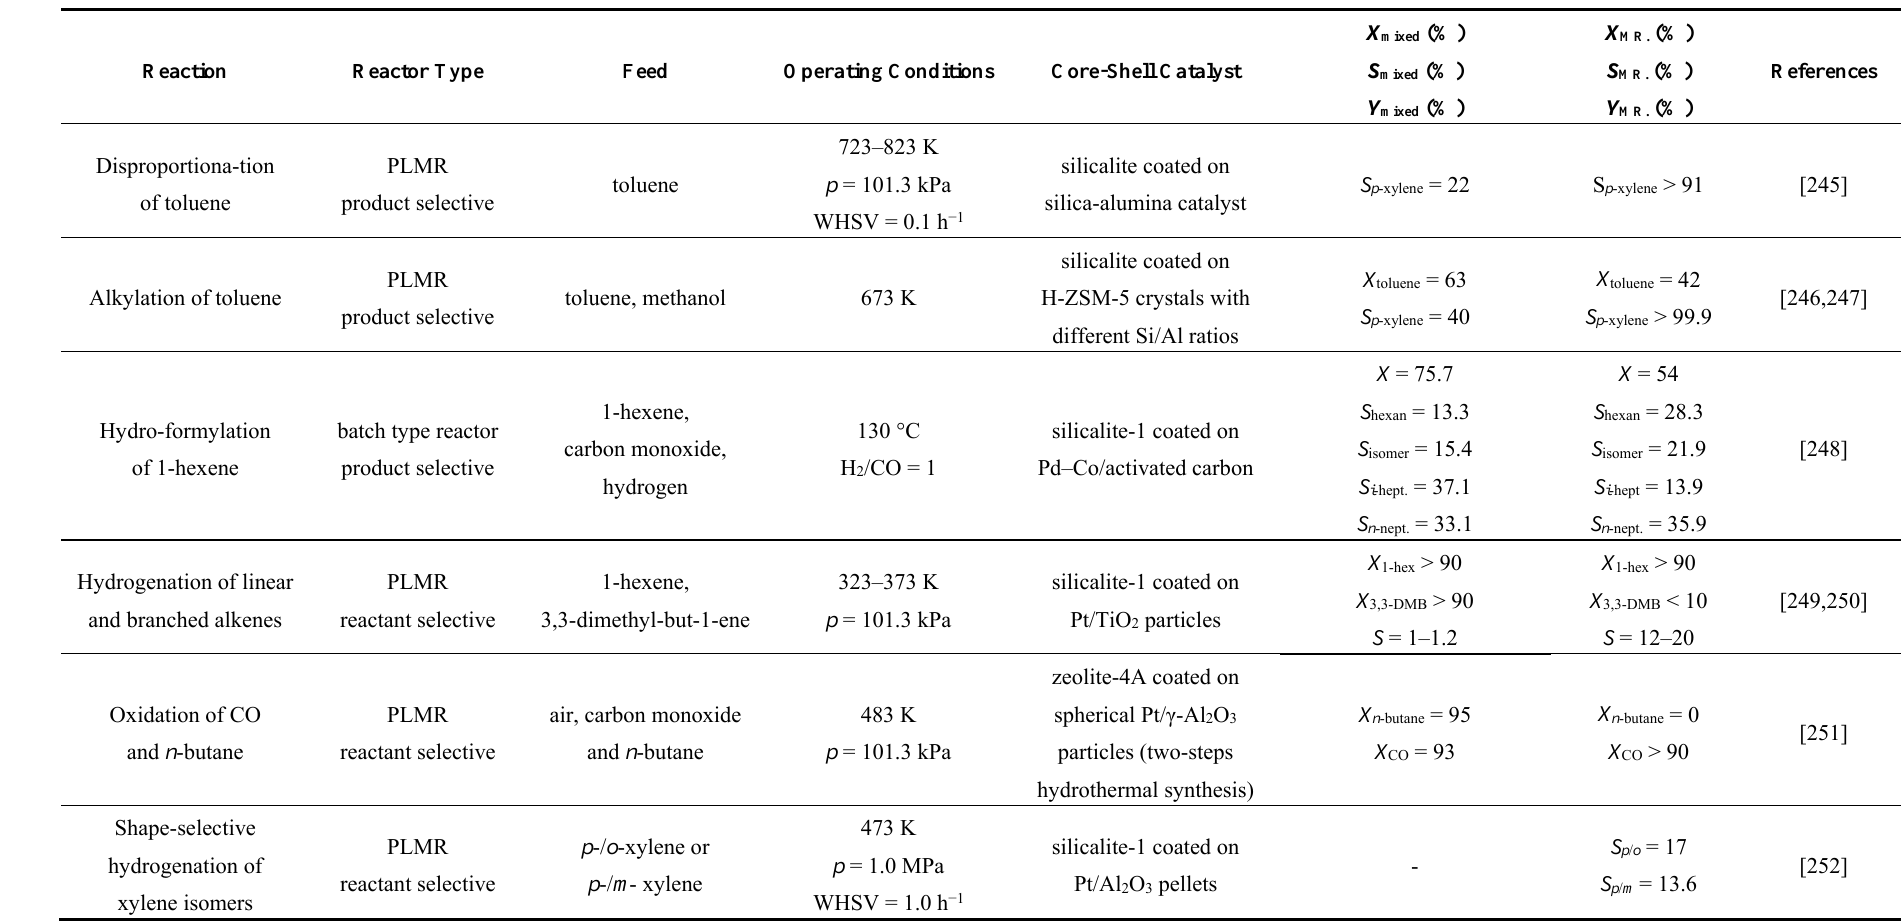
Table 2. Overview of the application of packed bed reactor consisting of permselective membrane coated catalyst particles reported in the